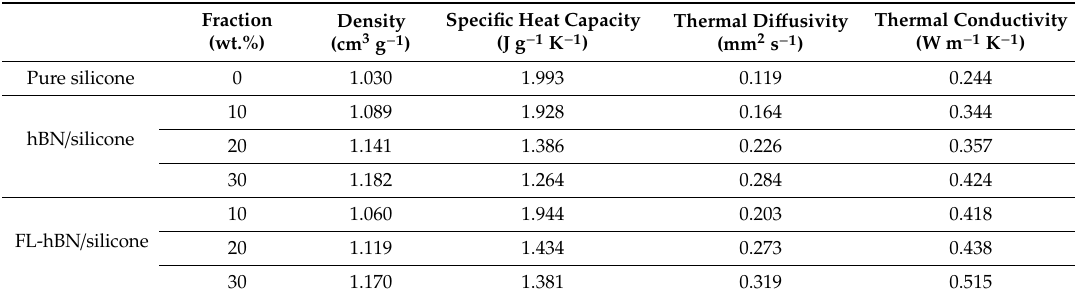
Figure 7. ( a ) Thermal diffusivity and ( b ) thermal conductivity of h-BN/silicone composites and FL-hBN/silicone composites. Table 1. The physical properties of all the